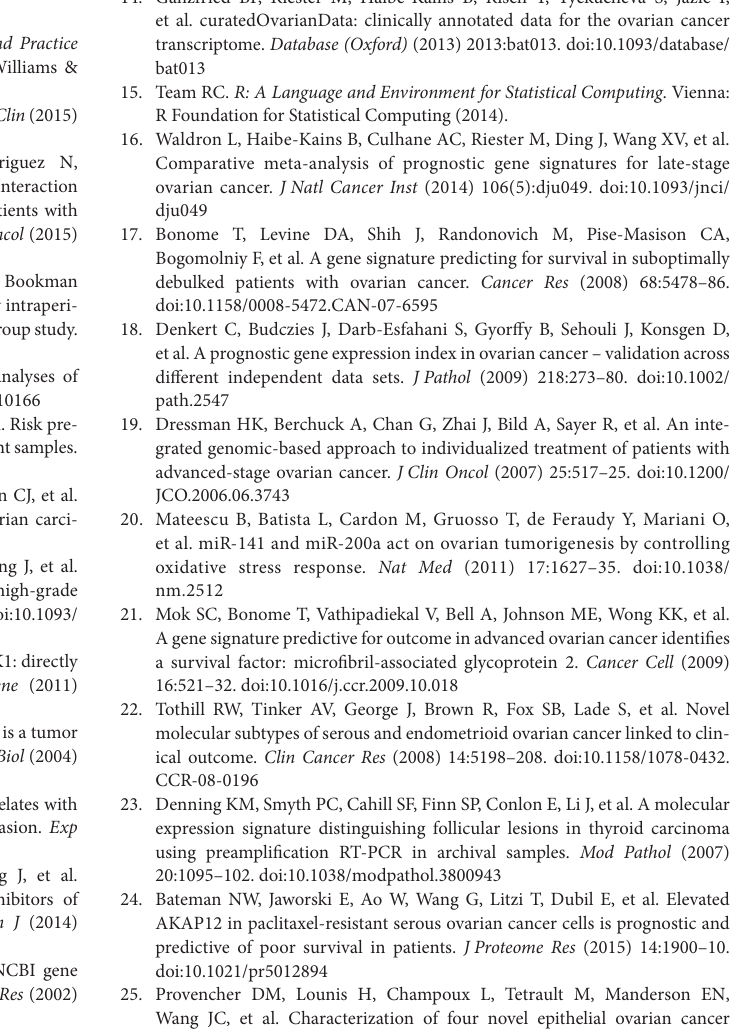
TaBle s1 | Univariate and multivariate modeling of nUaK1 transcript expression and overall survival in discovery ( n = 1262) and validation ( n = 174) cohorts . TaBle s2 | Univariate and multivariate modeling of nUaK1 transcript expression and overall and progression-free survival in discovery ( n = 802) cohorts .